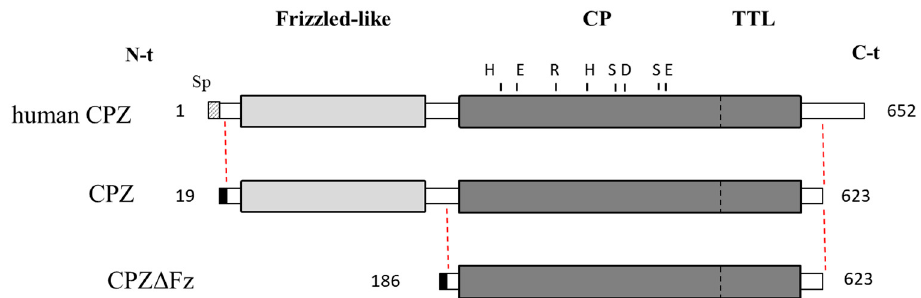
Figure 1. Schematic representation of human metallocarboxypeptidase Z (CPZ) and its recombinant forms. Full-length human CPZ (UniProtKB accession number Q66K79) and the recombinant CPZ forms used in this work are represented. Key residues essential for the catalytic mechanism are indicated: His69, Glu72, Arg145, His198 and Glu270 (numbering based on the mature form of bovine CPA, by convention in the field). Positions of residues Ser387, D391 and Ser457 of CPZ (equivalent to Leu203, Gly207 and Ile255 in bovine CPA, respectively) are also indicated. The recombinant form CPZ lacks 29 residues in its C-terminal region. The recombinant form CPZ ∆ Fz, in addition to the C-terminal truncation, lacks 167 residues in its N-terminal tail, corresponding to the Frizzled-like (Fz) domain.